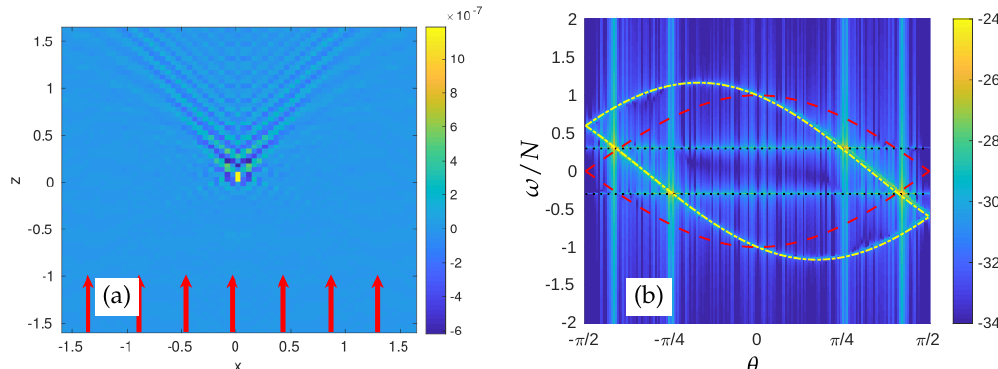
Figure 4. Sweeping effect of a homogeneous vertical mean velocity field on the propagation of an internal gravity wave. ( a ) Vertical velocity u z in the ( x , z ) plane in physical space where the red arrow illustrate vertical velocity with c z = 10 − 2 (zoomed in). ( b ) The corresponding concentration of energy density E ( θ , ω ,56 < k ≤ 60 ) in the ( θ , ω ) Fourier domain (in log scale). Red dashed line: original dispersion relation curve ω r ( θ ) for internal gravity waves defined by Equation (2). Black dotted line: forcing frequency ω f . Yellow dashed-dotted line: deviation of the dispersion relation for k = 60 defined by Equation